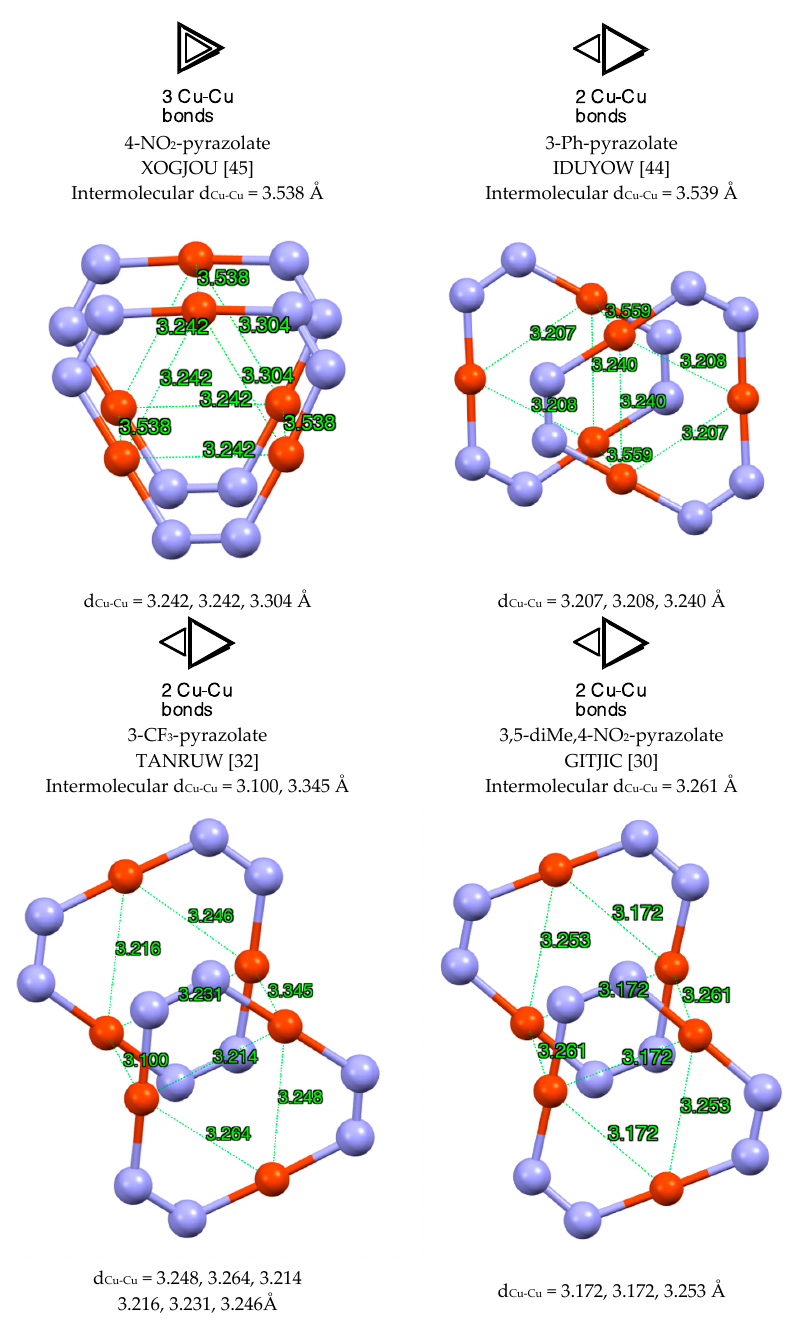
Figure 4. Di ff erent modes present in the “3 + 3” (pzCu) 3 complexes. Only the copper and nitrogen atoms are